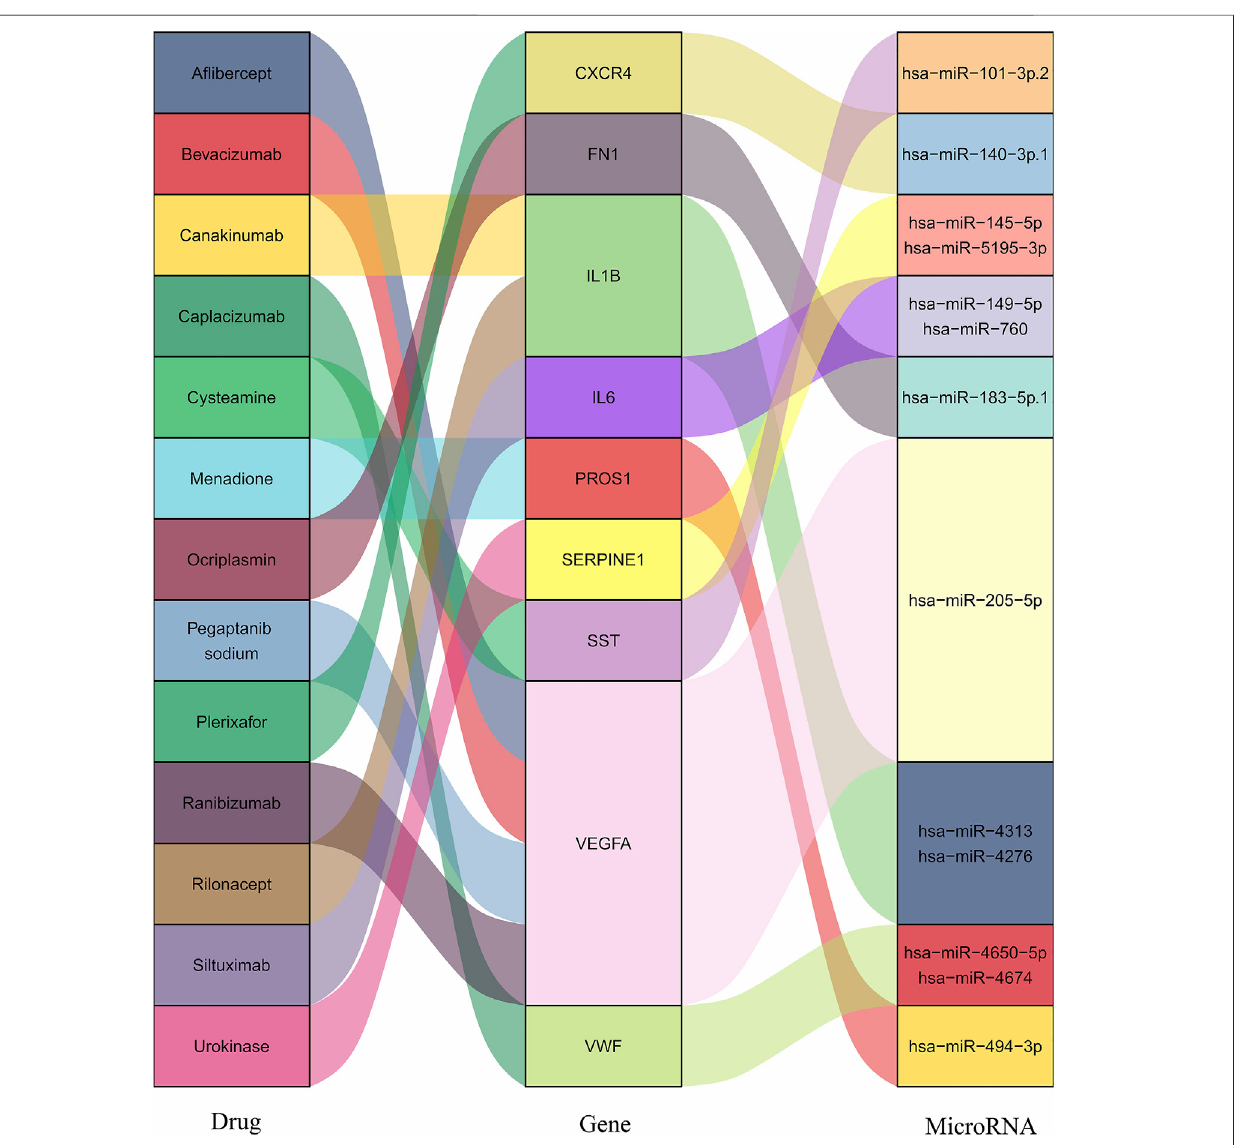
Frontiers in Genetics |